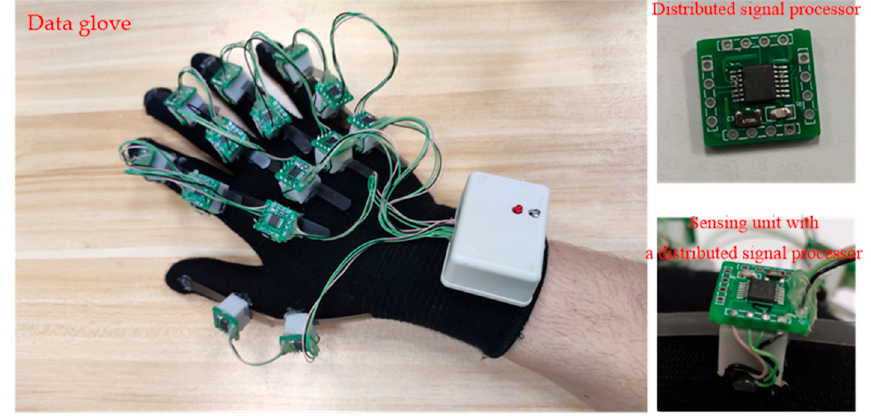
Figure 8. Photo of the designed wireless data glove.